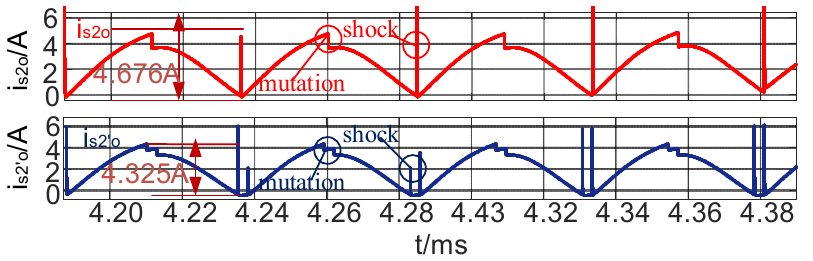
Figure 18. Traditional topological on-load 180 ◦ phase-shifting input current waveform.